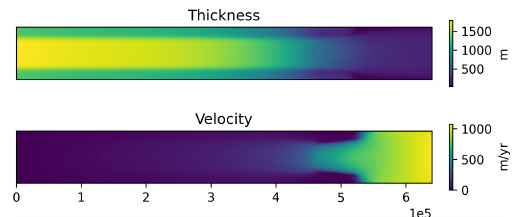
Figure 3. The steady-state thickness and velocity of the MISMIP+ experimental setup with the modified Schoof sliding law of Eq. (45).